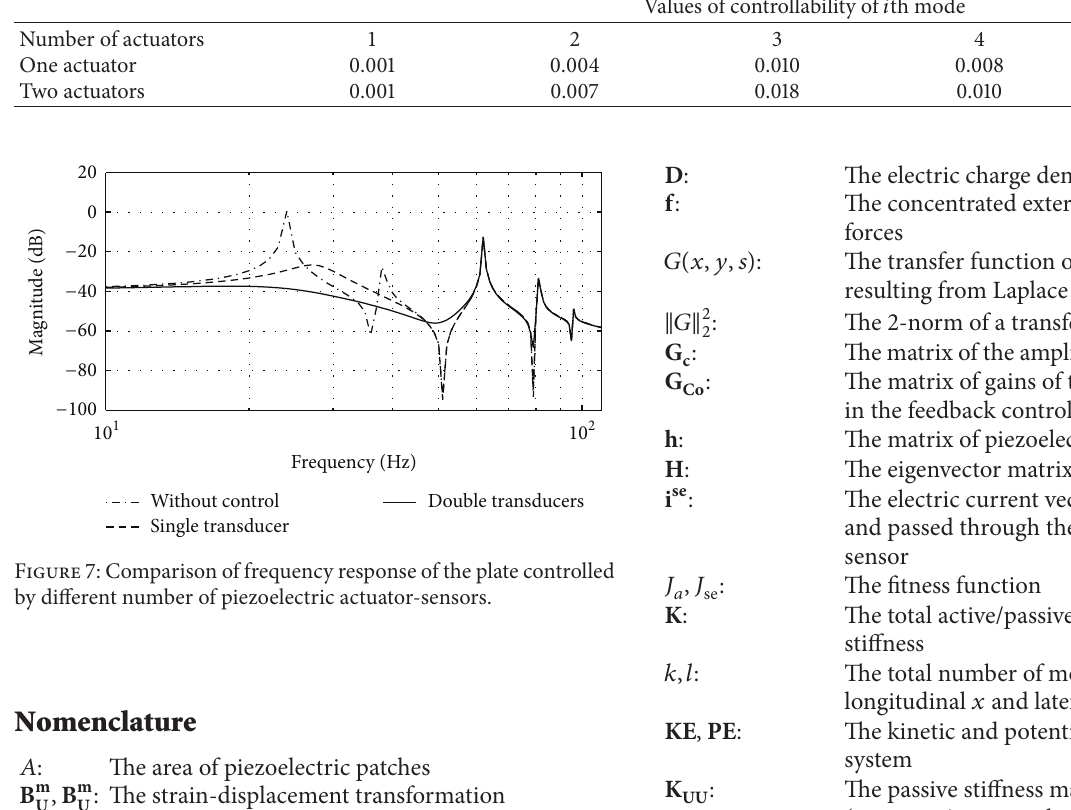
Table 11: The effect of values of controllability for random location, whenever the first two modes are controlled. Values of controllability of 𝑖 th mode